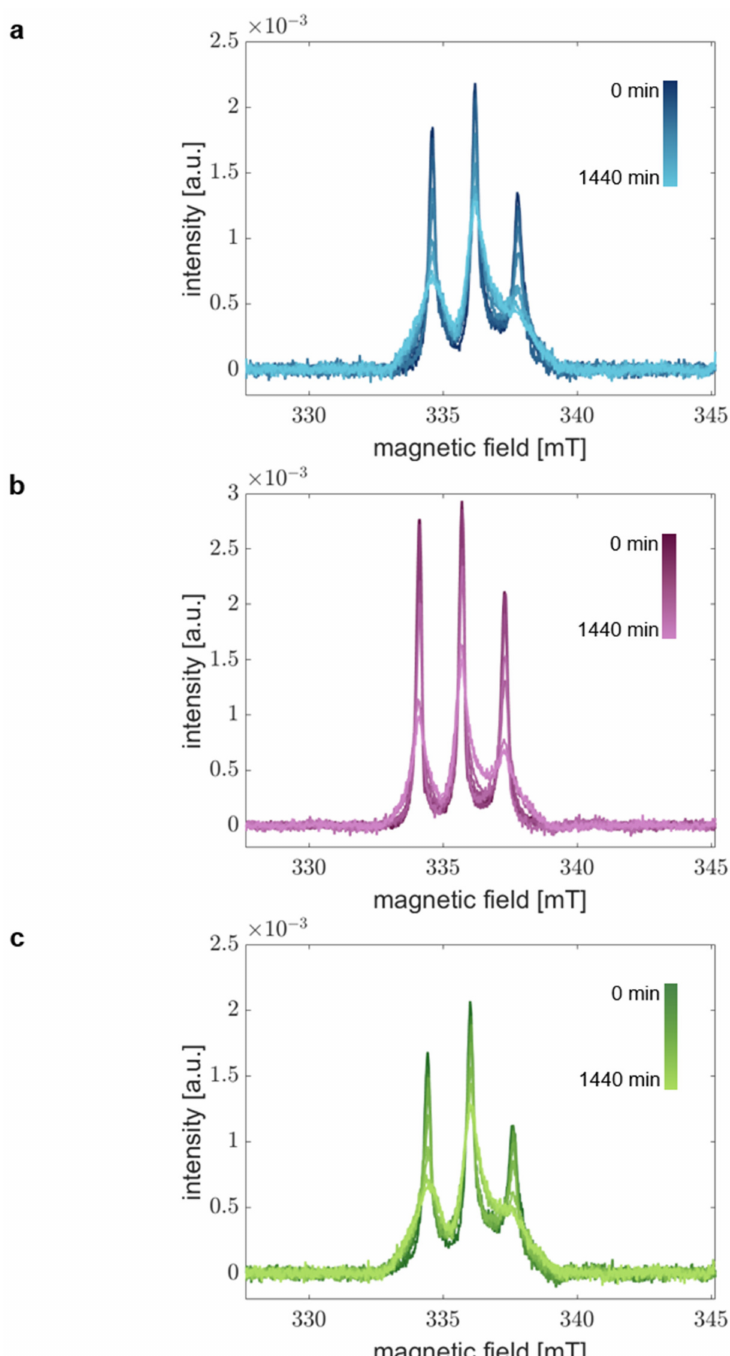
Figure 3. Time-resolved absorption spectra demonstrate aggregation of aS. Room-temperature RS EPR spectra of ( a ) aS A27C-MTSSL, ( b ) aS A30P-A27C-MTSSL, and ( c ) aS A53T-A27C-MTSSL. aS was aggregated at 37 ◦ C and 600 rpm in the presence of 20% EtOH. Samples at different time points in the range of 0–1440 min were acquired in